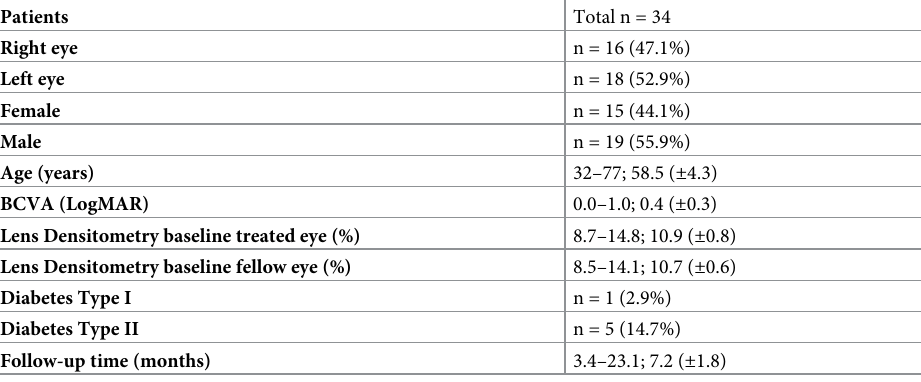
Table 1. Demographics and presurgical